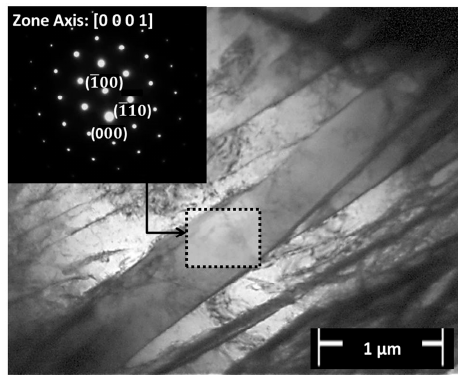
Figure 12. TEM BF image of Widmanstätten microstructure of Ti-6Al-4V with respective SAED pattern oriented in the [0001] α -Ti zone axis from Region 4 of Figure 11f.